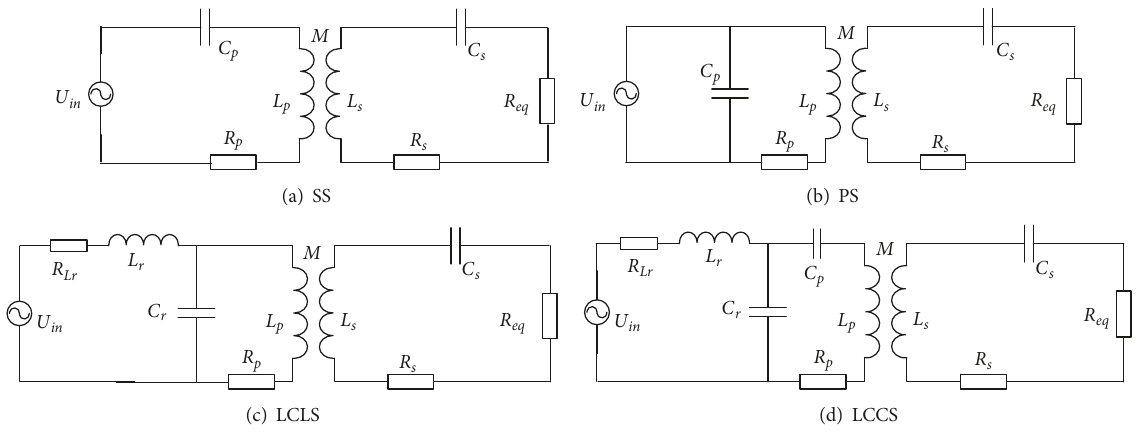
Figure 4: Four resonant compensation topologies. Table 2: Four topological parameter